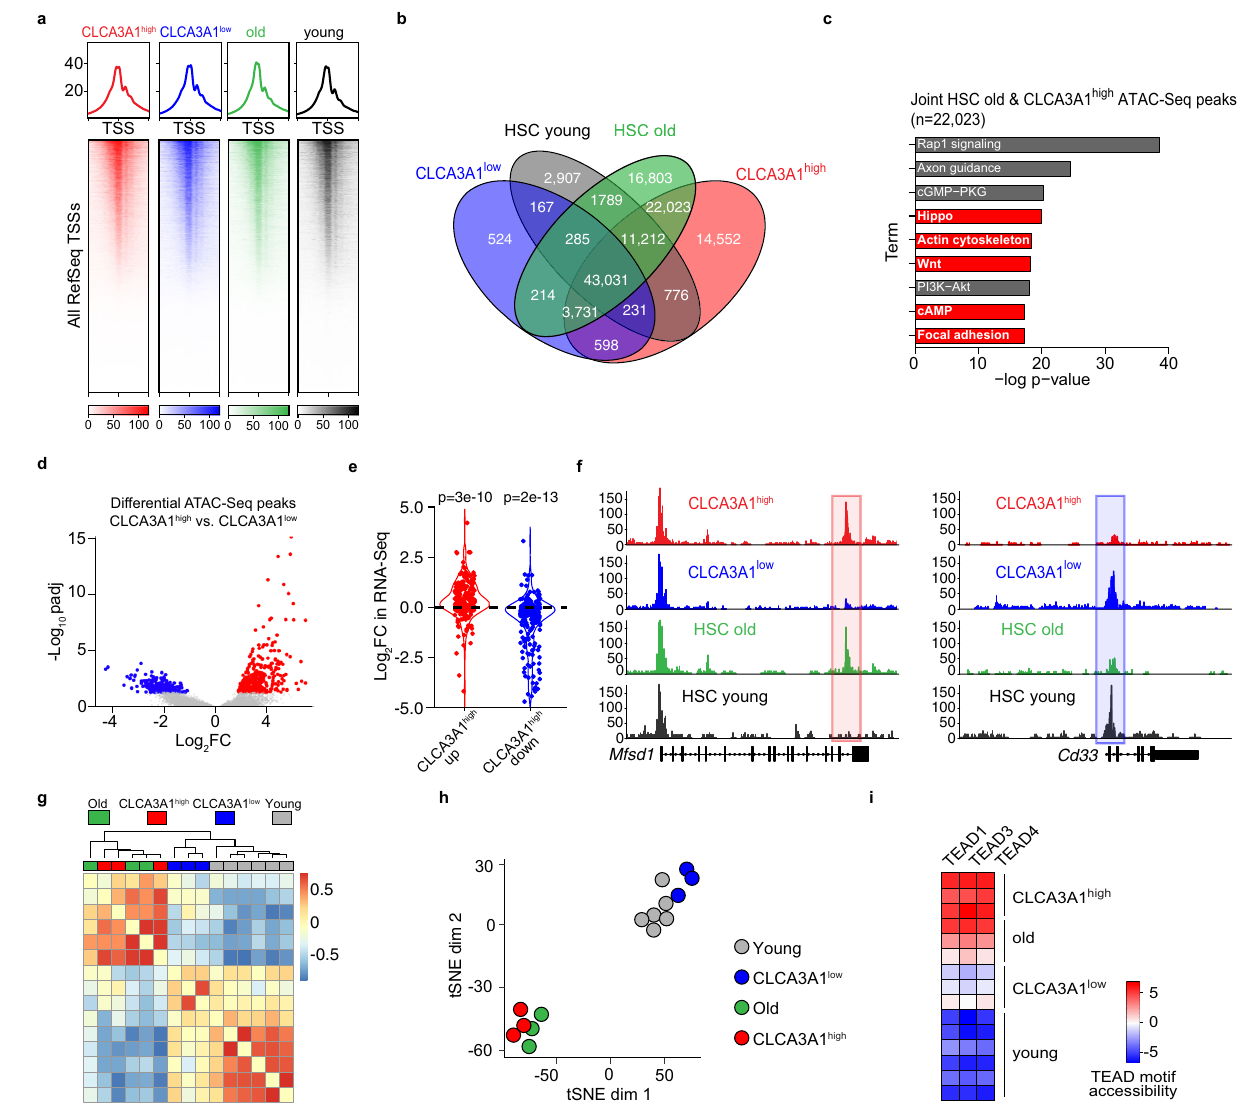
Fig. 5 | CLCA3A1 low HSCs resemble yHSCs on chromatin level. a Heatmaps for FAST-ATAC data of CLCA3A1 high , CLCA3A1 low LT-HSCs, oHSCs and yHSCs ( n =3 for CLCA3A1 low ,CLCA3A1 high andHSCold; n =6forHSCyoung).Alltranscriptionalstart sites (TSSs) were included and sorted according to the strongest signal. b Venn diagram of FAST-ATAC peaks. c Gene ontology analysis of FAST-ATAC peaks and their associated genes that are unique to oHSCs and CLCA3A1 high . The top 10 pathwaysaredepicted. d VolcanoplotfordifferentialFAST-ATACpeakscomparing Clca3a1 high vs.Clca3a1 low LT-HSCs.padj=adjusted p -value,FC=foldchange. e Violin plots for the regulation in the RNA-seq dataset of genes that are associated with a